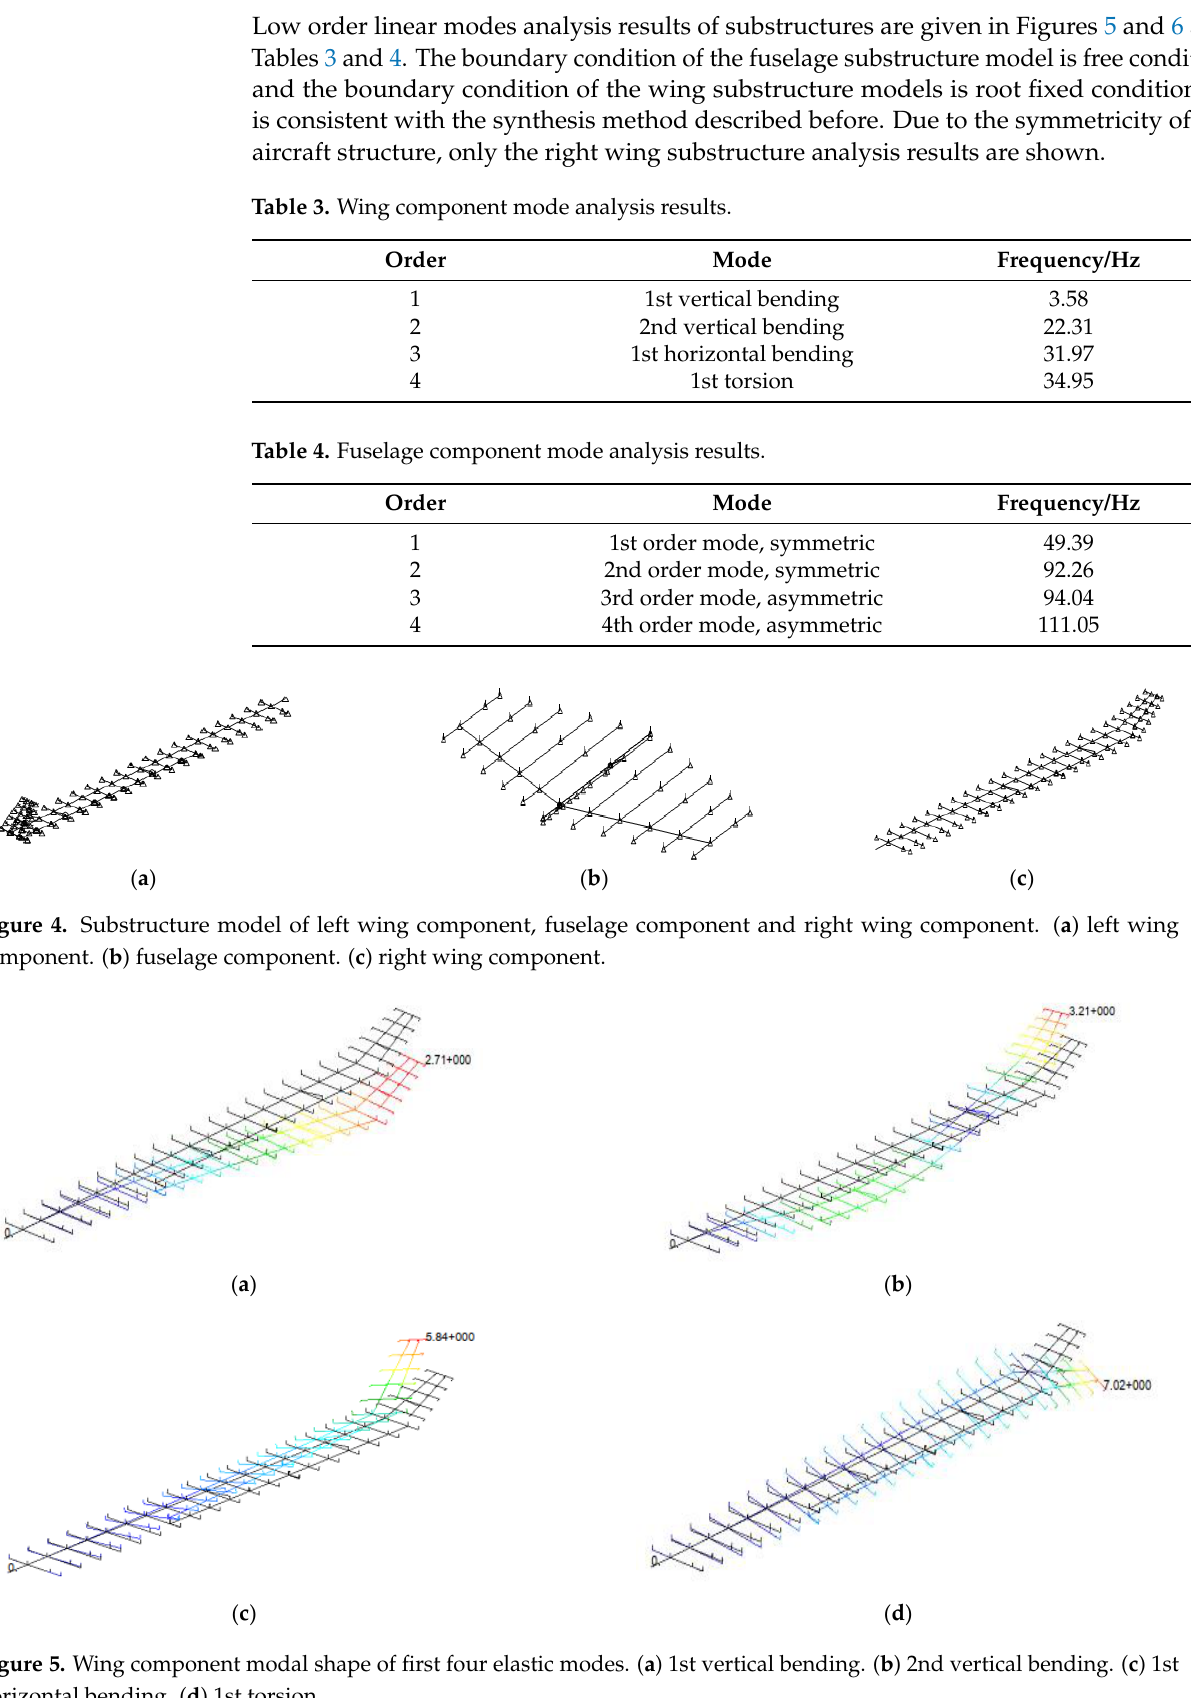
Figure 3. Modal shape of first eight elastic modes. ( a ) 1st symmetric vertical bending. ( b ) 2nd asymmetric vertical bending. ( c ) 2nd symmetric vertical bending. ( d ) 3rd asymmetric vertical bending. ( e ) 1st symmetric horizontal bending. ( f ) 1st asymmetric torsion. ( g ) 1st symmetric torsion. ( h ) 3rd symmetric vertical bending. Table 2. Elastic modes analysis results.